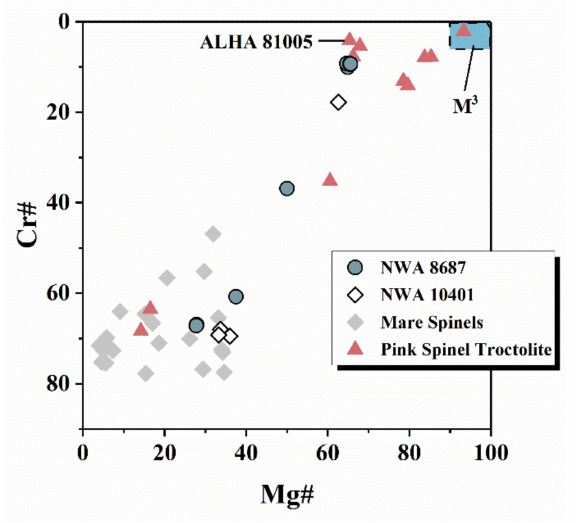
Figure 6. Spinel composition in NWA 8687 relative to compositional range from M 3 (after Ref. [21]); also compared with spinel in pair stone NWA 10401 [15], as well as in mare basalts [45] and pink spinel troctolites